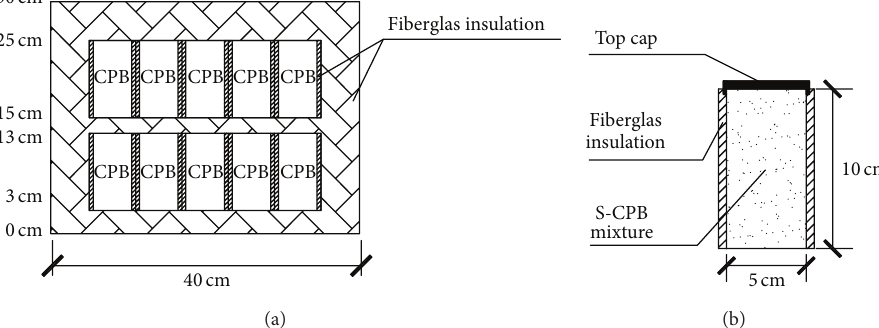
Figure 2: Schematic of the experimental curing setup: (a) location of cylinders in the insulation box and (b) illustration of the thermal insulating